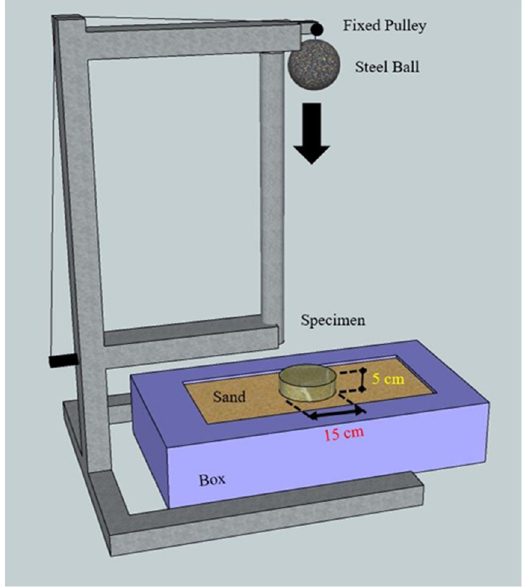
Figure 2. The illustration configuration of the impact test instruments.